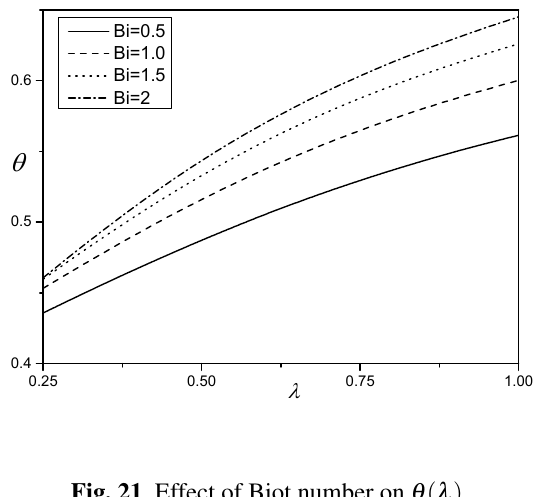
Fig. 21 Effect of Biot number on θ ( λ